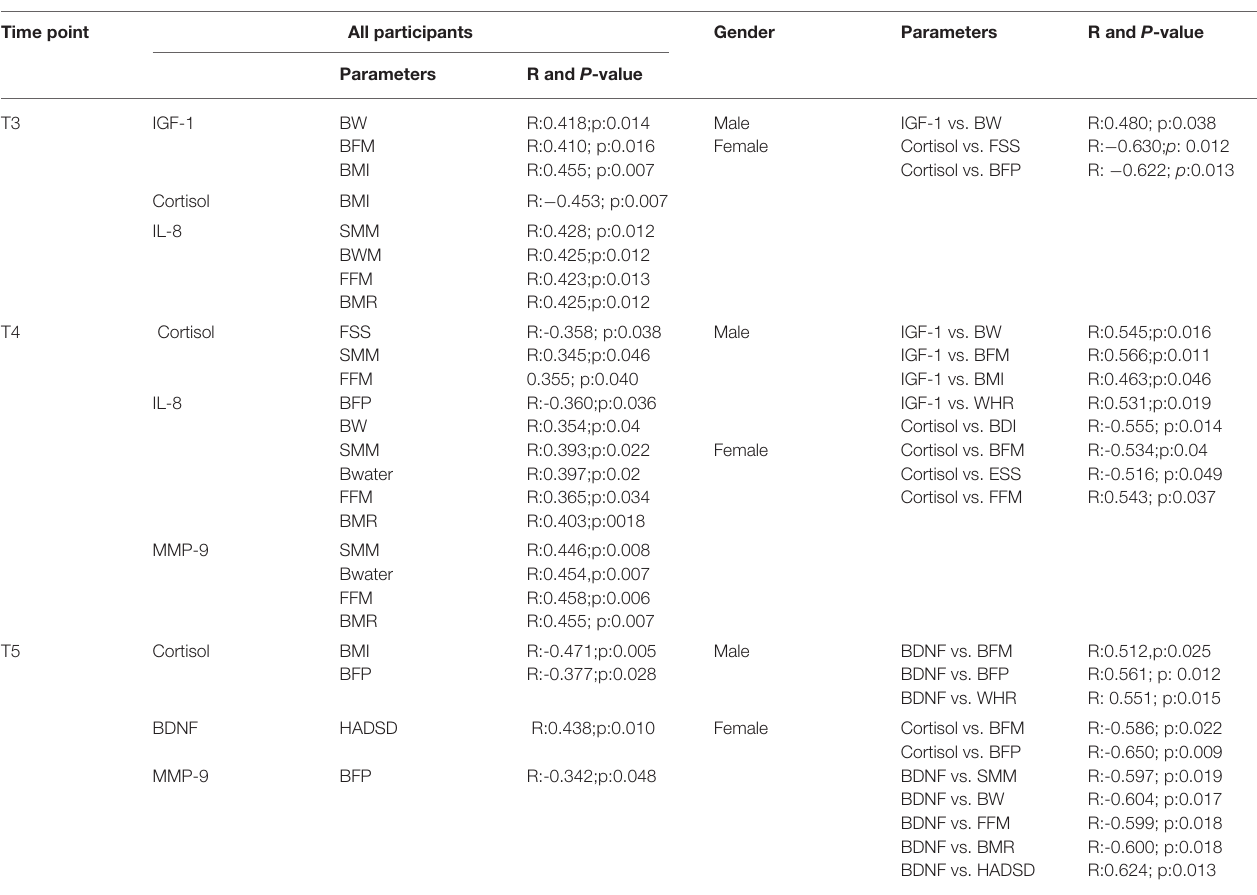
TABLE 3 | Correlation between biological mediators and clinical parameters in all, male, and females participants. Time